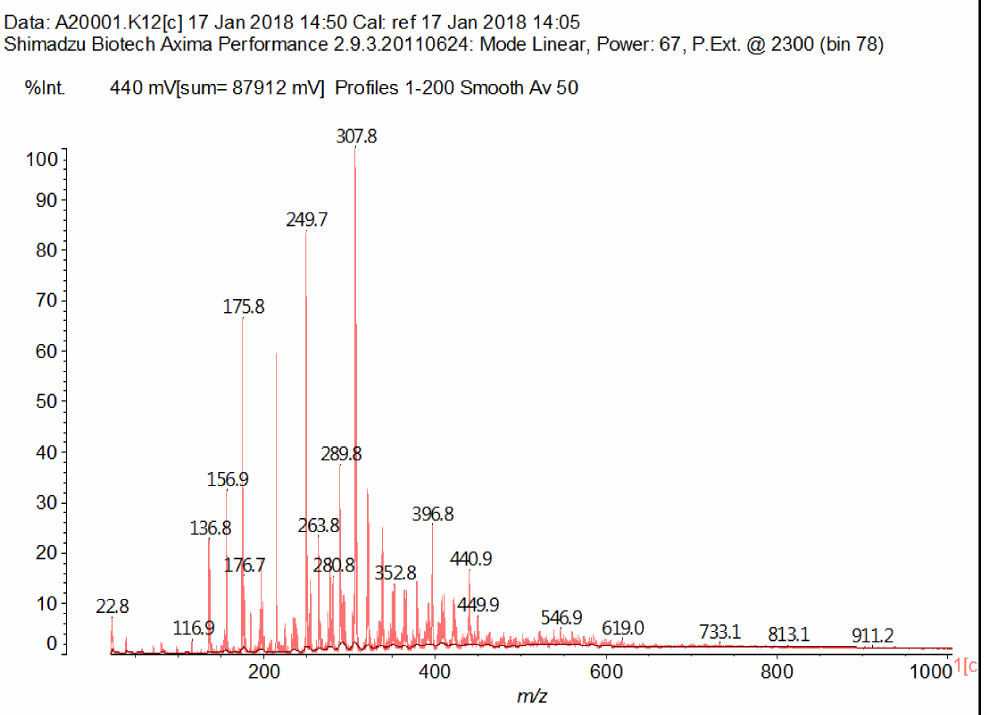
Figure 8. MALDI ToF spectrum of the A2 NIPU resin: 20–1000 Da range.